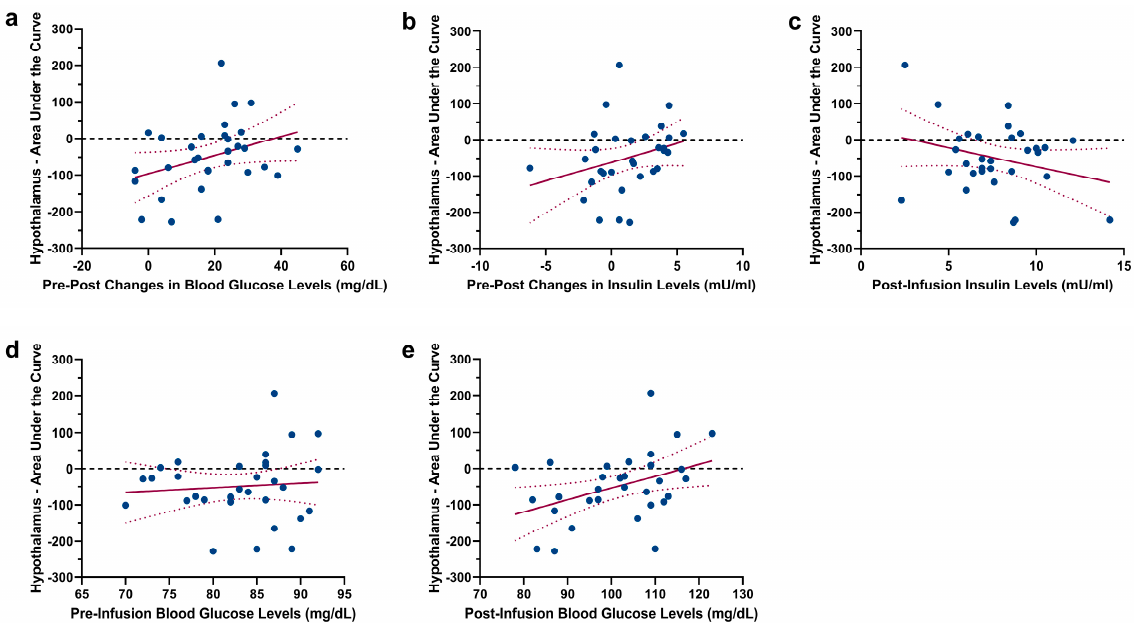
Figure 3. Scatterplots showing the non-significant association between the AUC of hypothalamic reactivity following glucose injection and ( a ) changes in blood glucose levels (pre-infusion levels vs. post-infusion levels), ( b ) changes in insulin levels (pre-infusion levels vs. post-infusion levels), ( c ) post-infusion insulin levels, ( d ) pre-infusion blood glucose levels and ( e ) post-infusion blood glucose levels. Regression lines are depicted with 95% confidence bands.